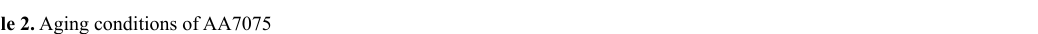
Table 2. Aging conditions of AA7075